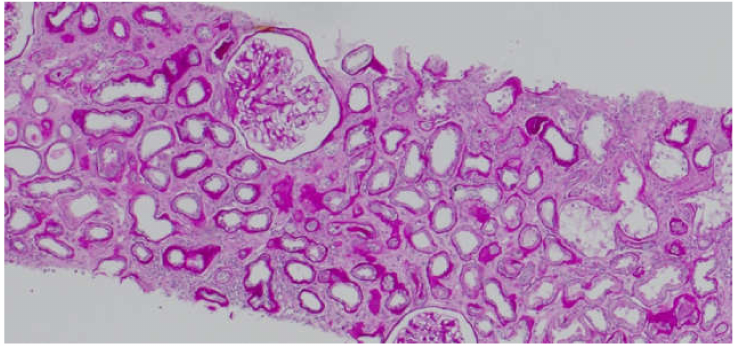
Figure 8. Histopathological image showing chronic changes graded as ci3,